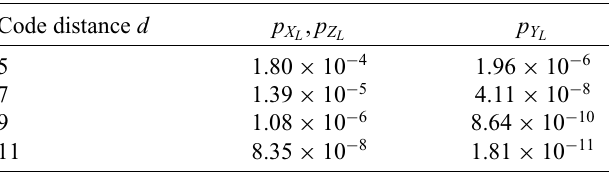
TABLE I. Estimated logical error probability for code dis- tances with p = 0.01 and p th ∼ 0.044.